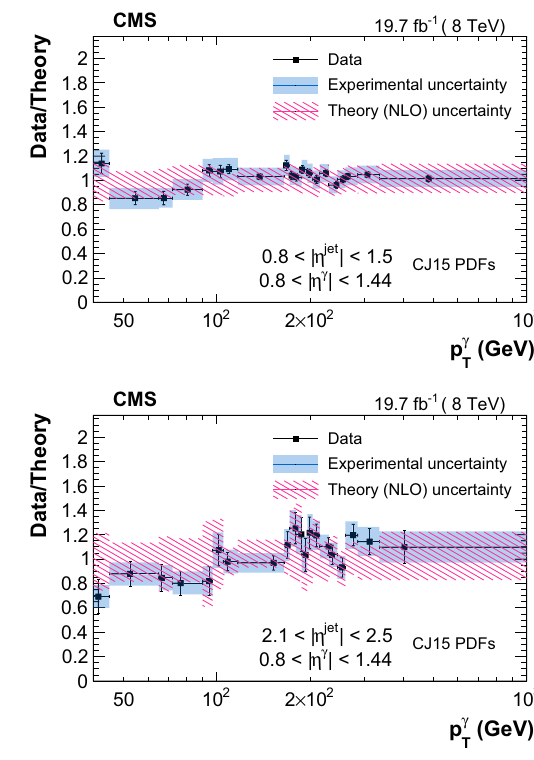
γ 0 . 80 < | η γ | < 1 . 44. Error bars on the data are statistical uncertainties, T and blue bands represent the systematic